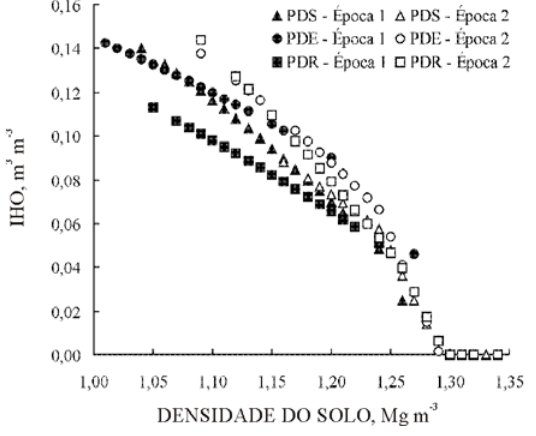
Figura 2. Variação do intervalo hídrico ótimo (IHO) com a densidade do solo para os três tratamentos e duas épocas. PDS (plantio direto com sucessão), PDR (plantio direto com rotação) e PDE (plantio direto com rotação e